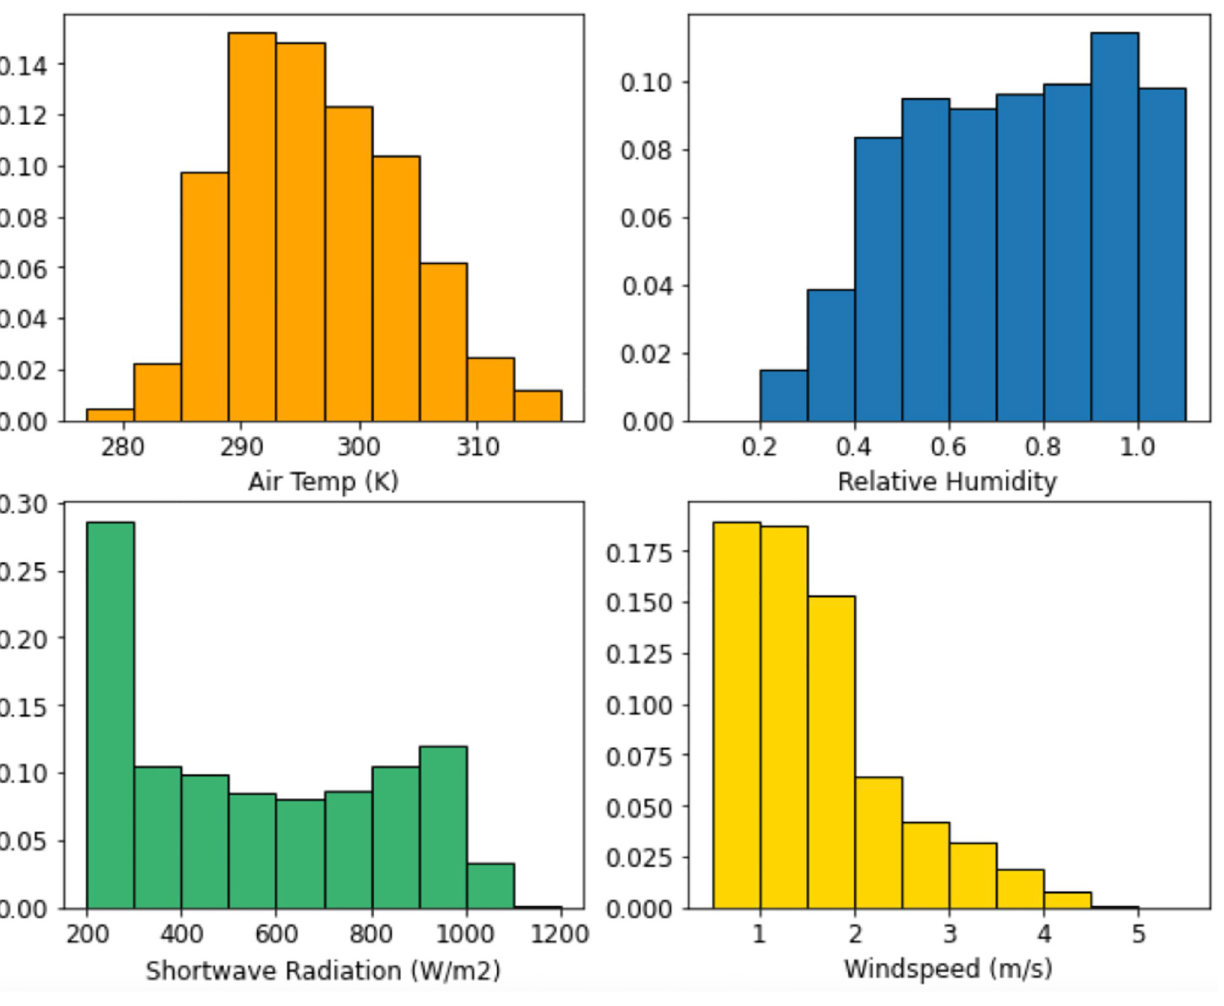
Fig 8. Weather parameter